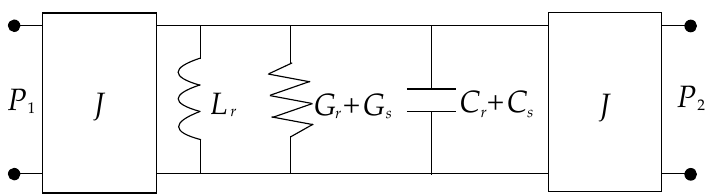
Figure 1. Parallel RLC lumped-element model of a microwave planar resonator loaded with a dielectric sample. The subscripts “r” and “s” refer to the contribution of the unloaded resonator and the sample to the respective element.